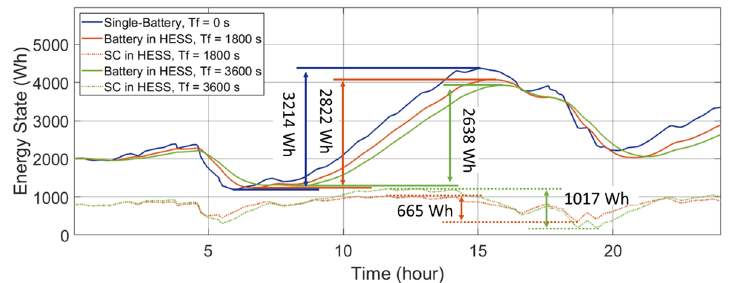
Figure 10. Energy states of the ESDs in the battery-SC HESS with different time constants in a wind-powered household-prosumer system.